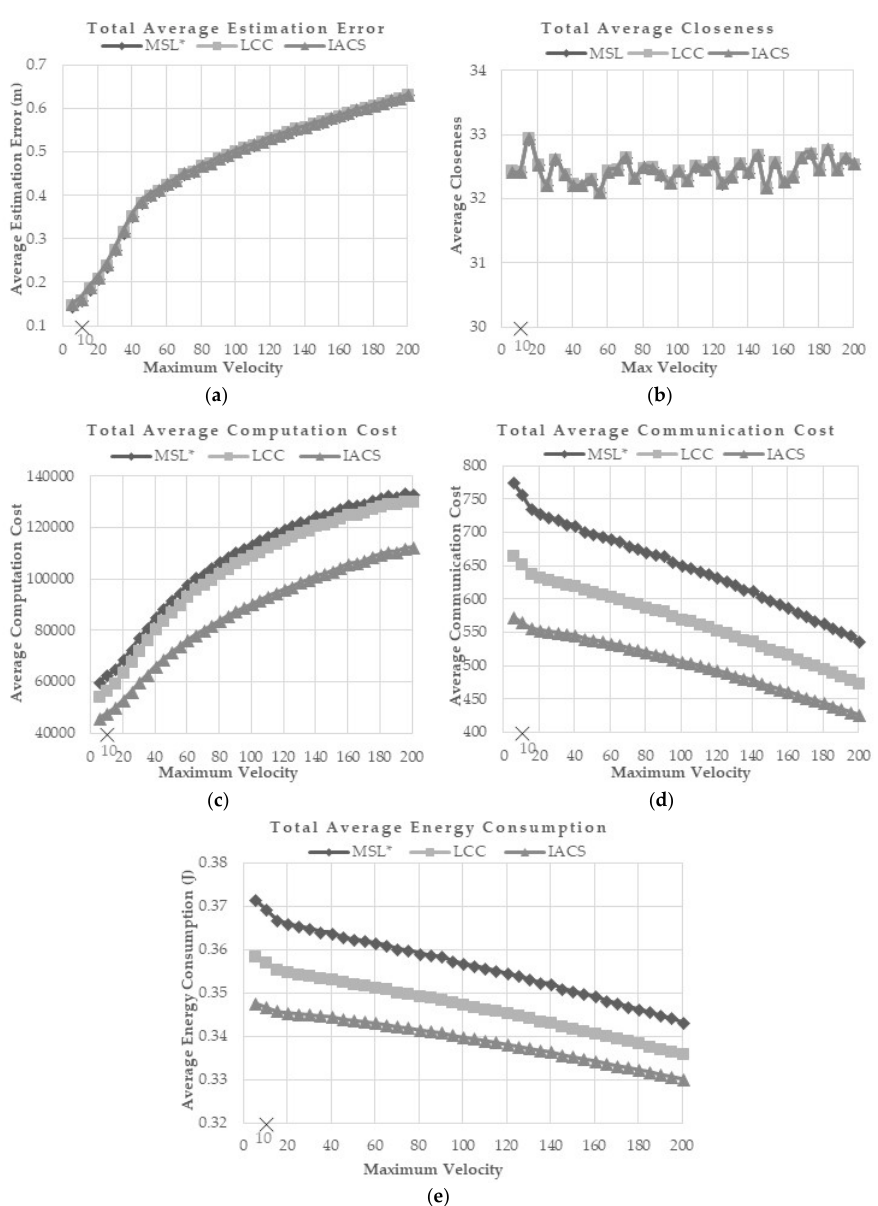
Figure 8 . ( a ) Total Average Estimation Error, ( b ) Total Average Closeness, ( c ) Total Average Computation Cost, ( d ) Total Average Communication Cost, and ( e ) Total Average Energy Consumption for Different Maximum Velocity Scenario. for Different Maximum Velocity